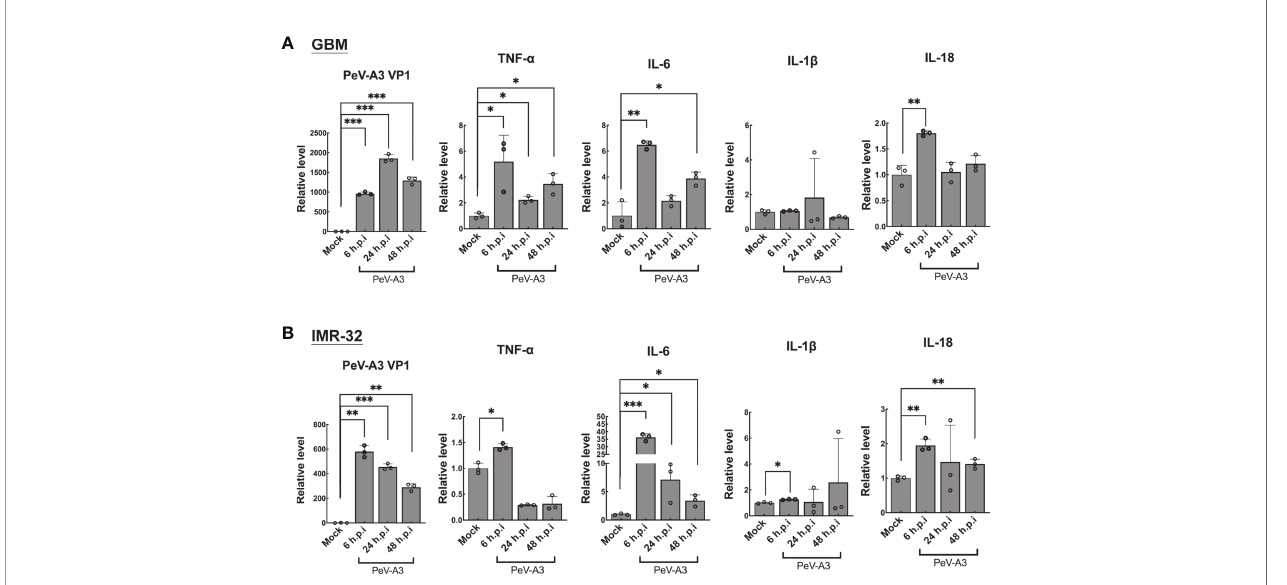
FIGURE 5 | PeV-A3 induced expression of pyroptosis-associated in fl ammatory cytokines. (A) GBM cells and (B) IMR-32 cells were infected with PeV-A3 at MOI = 1 for 6, 24, and 48 h. TNF- a , IL-6, IL-1 b , and IL-18 were analyzed using RT-qPCR. Data are mean ± SD of three independent experiments. Student ’ s t-test * p < 0.05; ** p < 0.01; *** p < 0.001 compared with mock controls. PeV-A3, parechovirus type 3; GBM, glioblastoma; MOI, multiplicity of